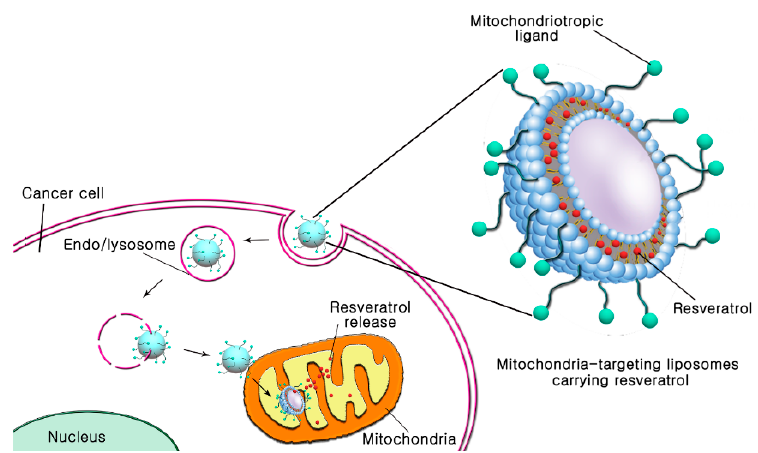
Figure 1. Schematic diagram to describe mitochondriotropic liposomes for enhanced subcellular trafficking of resveratrol in cancer cells. Mitochondria-targeting liposomes carrying resveratrol were constructed by modifying the TPP-DSPE-PEG (TLS (Res)) or DQA-DSPE-PEG (DLS (Res)) on the surface of liposomes.